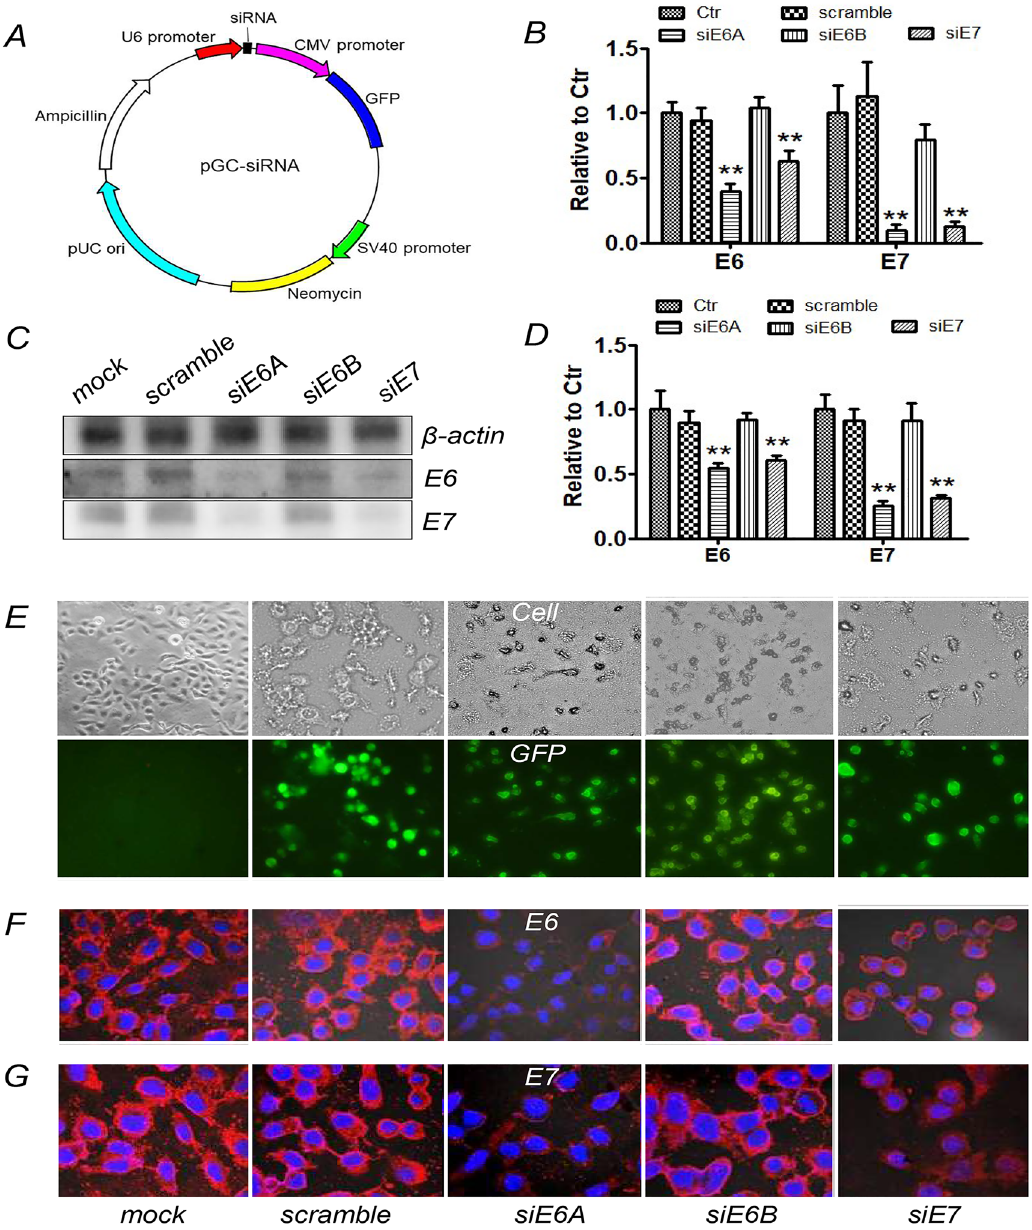
Figure 3. After transfection with pGC-siE6A or pGC-siE7 plasmid, the expression of HPV-E6/E7 protein was decreased in Siha cells. ( A ) The map of pGC-siRNA. ( B ) Semi-quantitative RT-PCR analysis of HPV16-E6/E7 mRNA in Siha cells transfected with pGC-siRNA plasmid. ( C , D ) Western blotting analysis of HPV16-E6 and HPV16-E7 protein in Siha cells transfected with pGC-siRNA plasmid. ( E ) Transfection efficiency determined by fluorescence microscope. ( F , G ) Immunofluorescence analysis for HPV16-E6/E7 protein in Siha cells transfected with pGC-siRNA plasmids (×